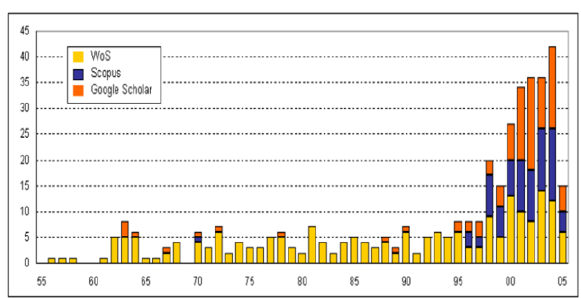
Figure 2. A few articles in Web of Science,